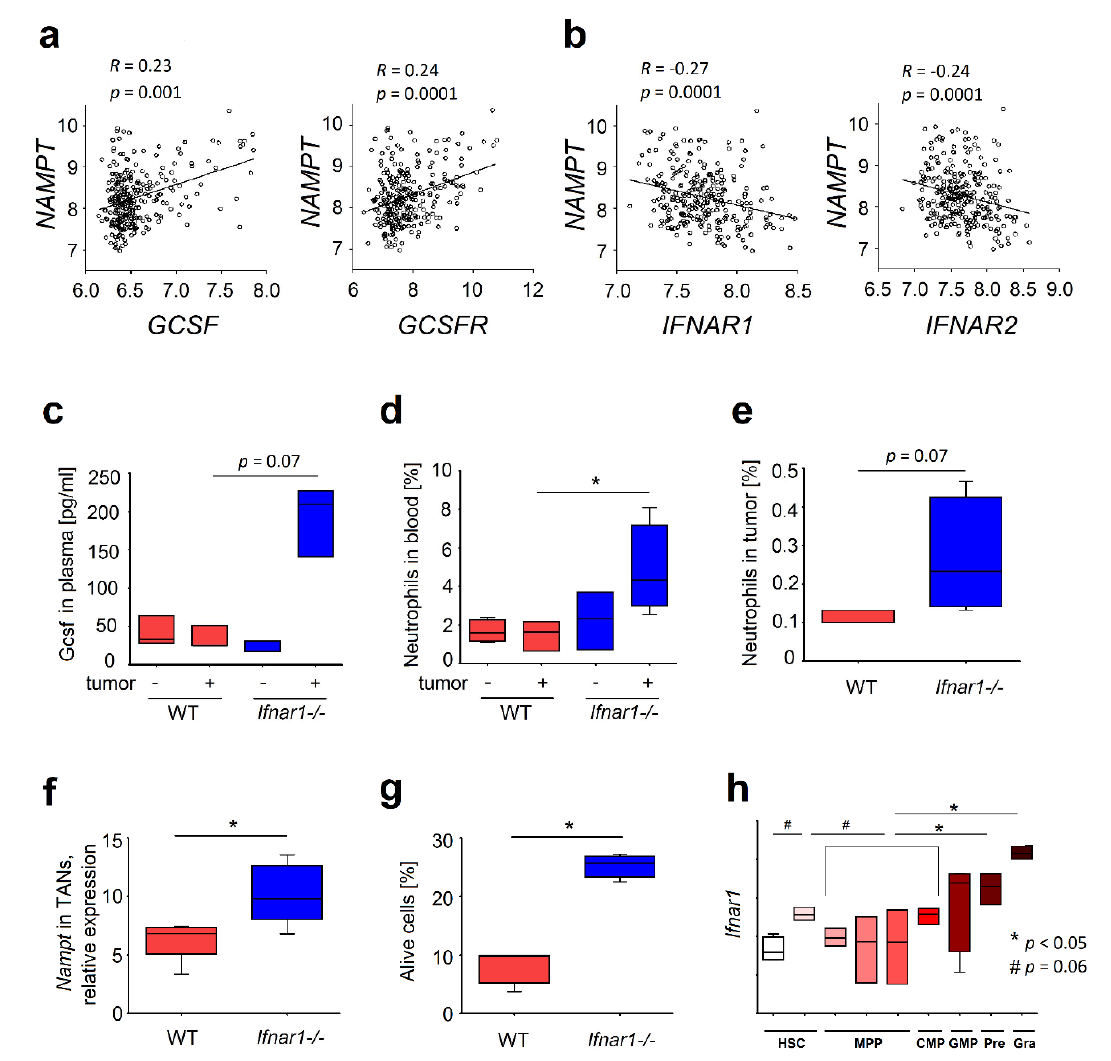
Figure 1. Expression of the granulocyte-colony stimulating factor (G-CSF) pathway and neutrophil infiltration depends on type I interferon availability during tumor development. ( a ) Positive correlation between nicotinamide phosphoribosyltransferase (NAMPT) and G-CSF genes and NAMPT and G-CSF-receptor (GCSFR) gene expression in the whole tumor cells population of head-and-neck cancer patients; ( b ) Negative correlation between NAMPT gene and interferon receptor ( IFNAR) subunit 1 and 2 gene expression ( IFNAR1, IFNAR2 , respectively) in tumor tissue of head-and-neck cancer patients. n = 270; ( c ) Up-regulated level of Gcsf in plasma of type I IFN receptor knockout ( Ifnar1 - / - ) tumor-bearing mice in comparison to wild-type (WT) mice; ( d ) Elevated percentage of neutrophils in blood and ( e ) tumor of tumor-bearing Ifnar1 - / - mice in comparison to WT mice; ( f ) Elevated Nampt gene expression in tumor-associated neutrophils (TANs) of Ifnar1 - / - mice in comparison to WT mice; ( g ) Survival of TANs in increased in Ifnar1 - / - mice; ( h ) Expression of Ifnar1 gene in di ff erent stages of granulopoiesis in WT mice. n = 3–4 mice per group. Data are presented as median, 25, 75 percentiles and minimal and maximal values. * p < 0.05. NAMPT: nicotinamide phosphoribosyltransferase.